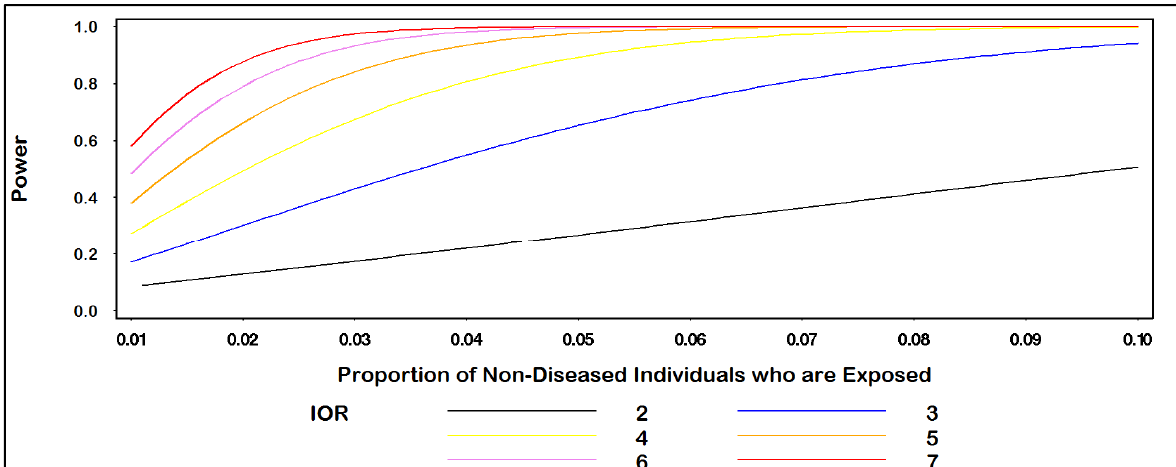
Figure 1. Power for IOR by proportion of non-diseased individuals who are exposed.